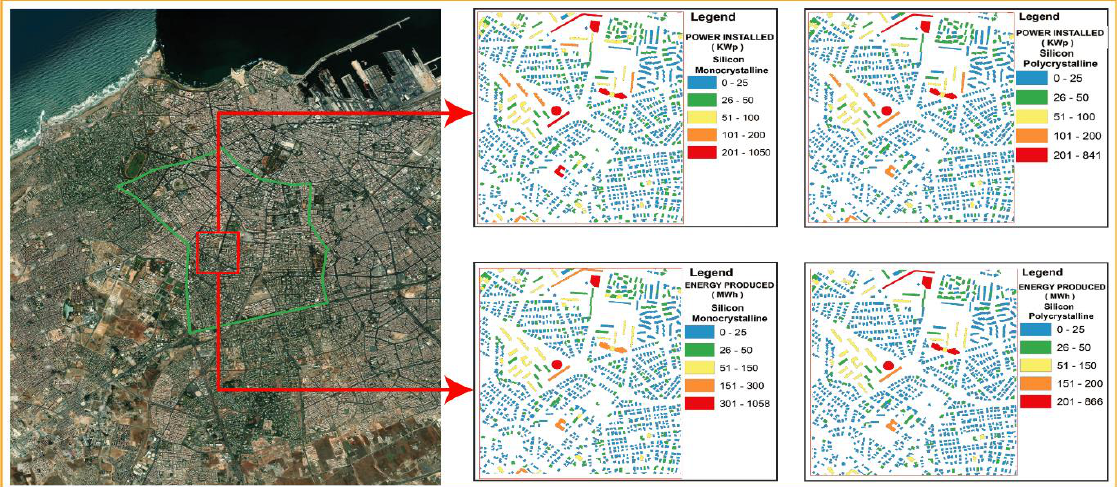
Figure 6. Example of results obtained relating to the installed power and annual energy produced by roofs using different types of photovoltaic